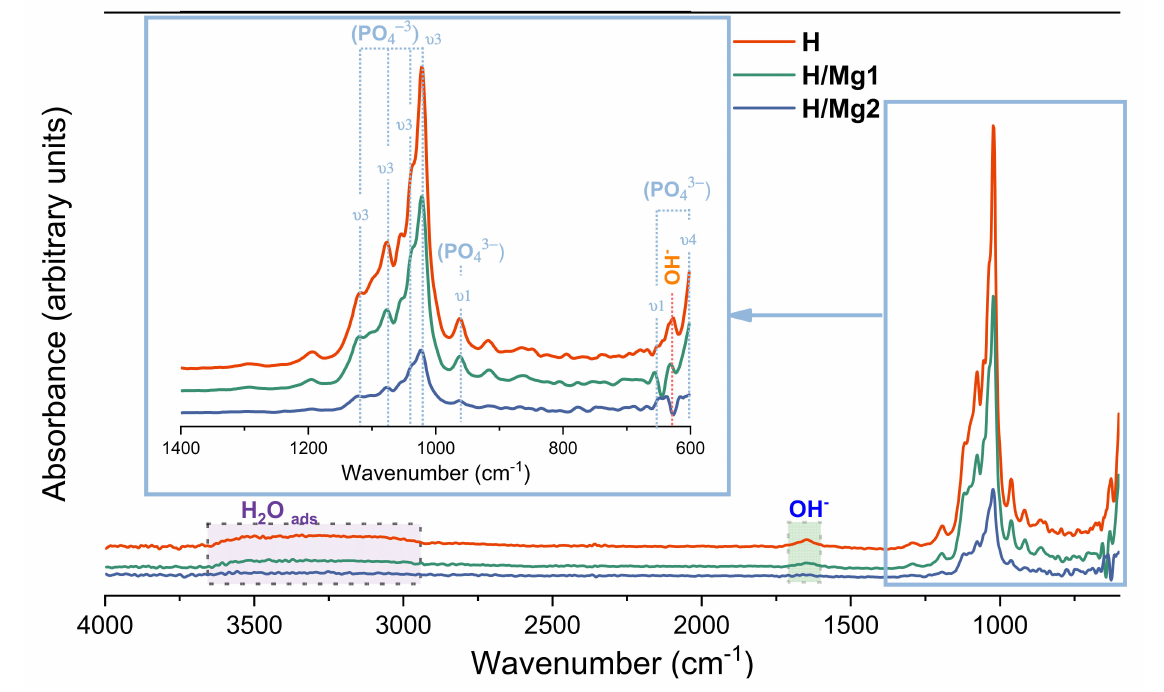
Figure 6. FTIR spectra of the HAp-based coatings deposited on the nanostructured